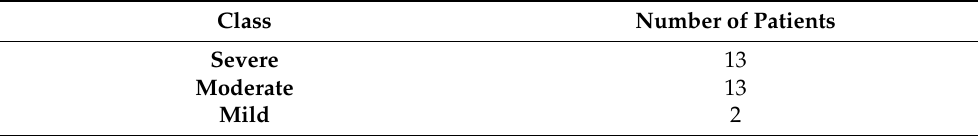
Table 3. Patients’ distribution considering the G index as a grouping